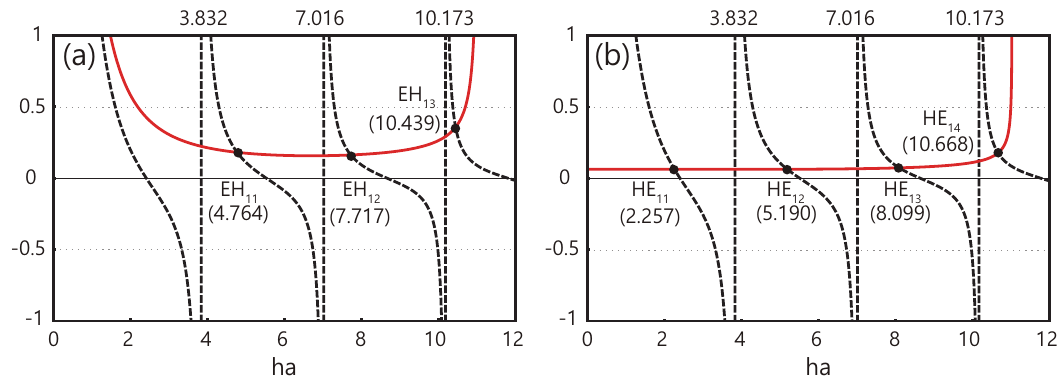
Figure 3. Solutions for the ( a ) EH modes and ( b ) HE modes of Equation (4) at V = 11.03. The right- and left-hand sides of Equation (4) are plotted by the solid-red and black-dashed lines, respectively.